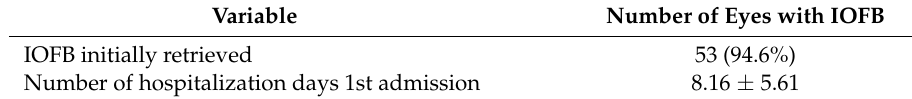
Table 3. Surgical